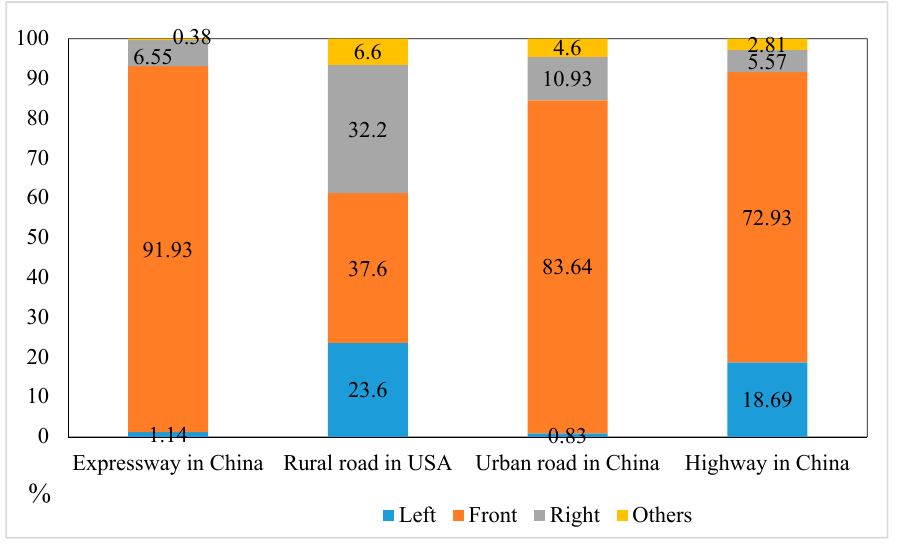
Figure 12. Comparison of di ff erent literature fixation